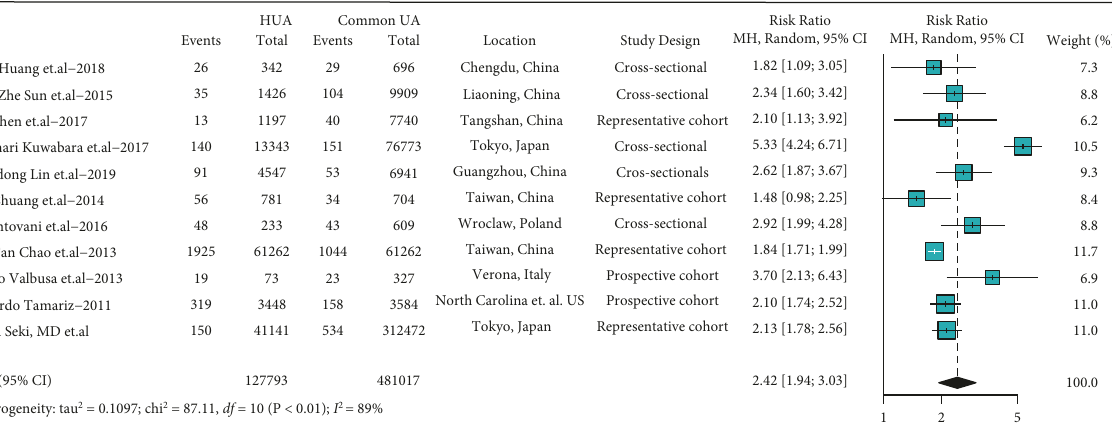
Figure 2: Difference in prevalence of AF between those with or without HUA. Point sizes are an inverse function of the precision of the estimates, and bars correspond to 95% CIs; HUA: hyperuricemia, common UA: individuals without HUA. Study or Subgroup Country = China Guo−Zhe Sun et.al−2015 Wei−dong Lin et.al−2019 S−Y Chuang et.al−2014 Tze−Fan Chao et.al−2013